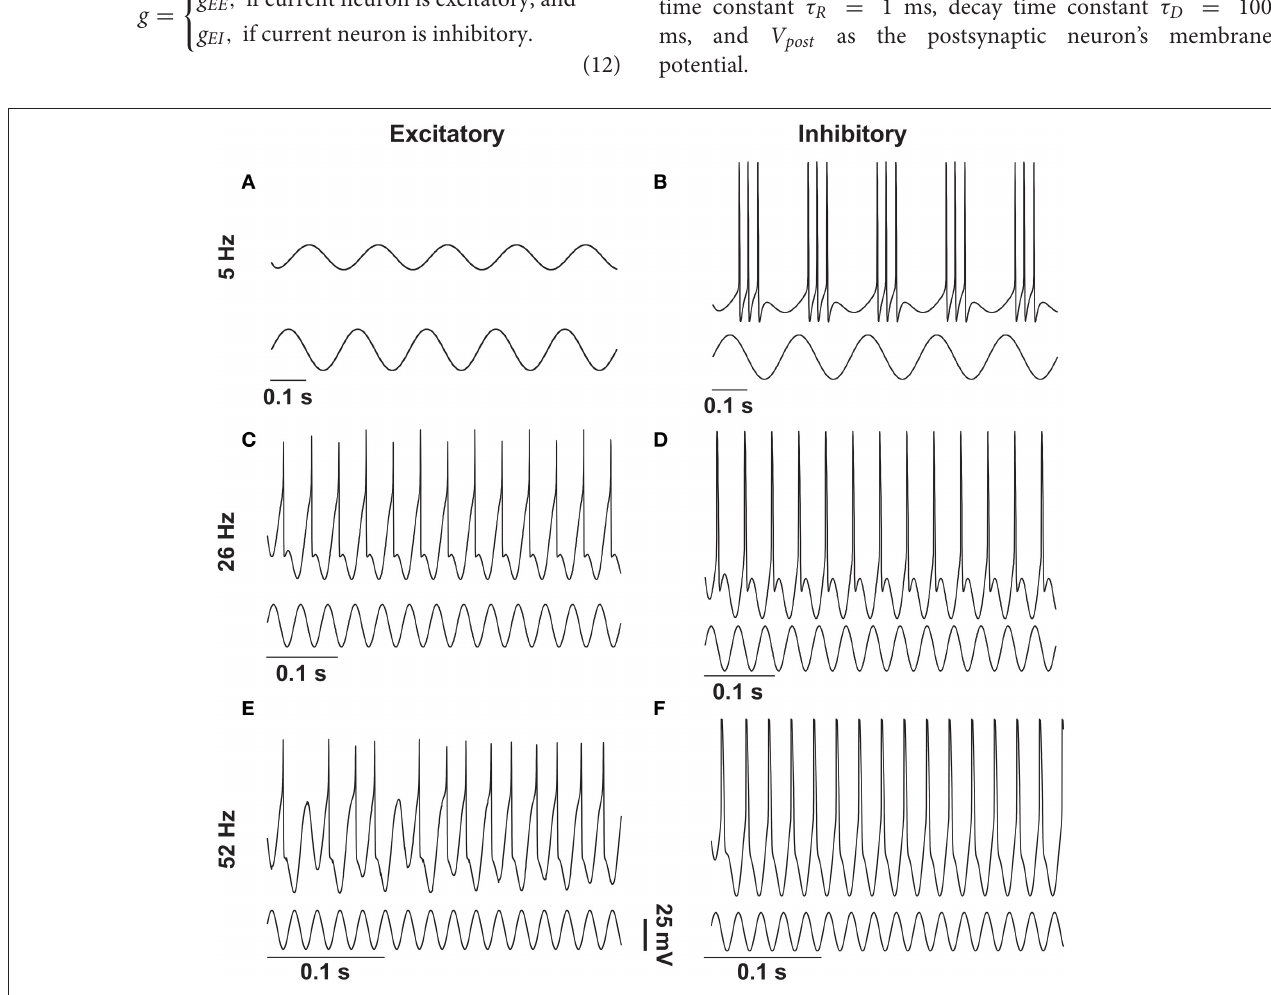
FIGURE 3 | Response of excitatory and inhibitory neurons to different frequencies of sinusoidal stimulations. Stimulating resting state excitatory and inhibitory neurons with different frequencies ( 5 Hz, 26 Hz, and 52 Hz) of sinusoids of 38 mV elicited different firing patterns as outlined in Figure 1 . In case of the excitatory neuron 5 Hz stimulation was not enough to elicit action potentials (A) , whereas the inhibitory neuron produced bursting activity (B) . For 26 Hz action potentials were elicited in both types of neurons in a phase-locked fashion (C,D) , and for 52 Hz the excitatory neuron moved to the intermittent region (E) and the inhibitory neuron still showed the phase-locked firing (F)